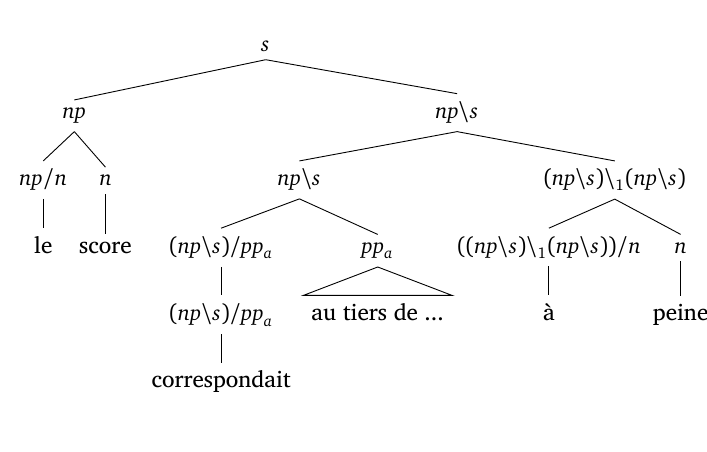
Figure 5: A version